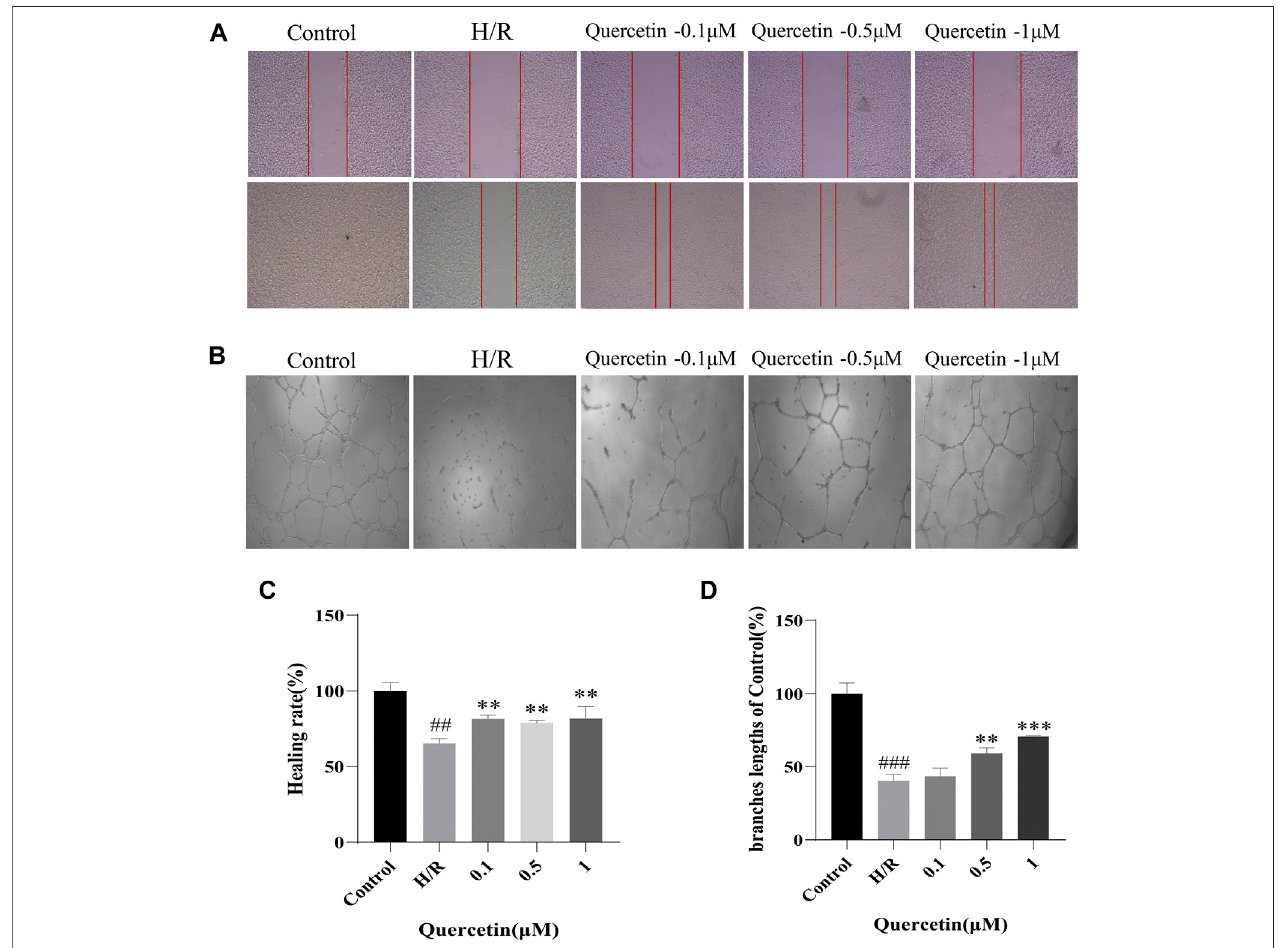
FIGURE 2 | (A) The distance between scratches in the presence of quercetin (0.1, 0.5, 1 μ mol/L) was measured using scratch method (B) The branches length of the tube under the different concentrations of quercetin (0.1, 0.5, 1 μ mol/L) was detected with tube formation method (C) Healing rate was calculated (D) Branches length data was displayed. ## p < 0.01, ### p < 0.001 compared to control group; ** p < 0.01, *** p < 0.001 compared to H/R group. μ M: μ mol/L; H/R: hypoxia and reoxygenation, n (cid:2)